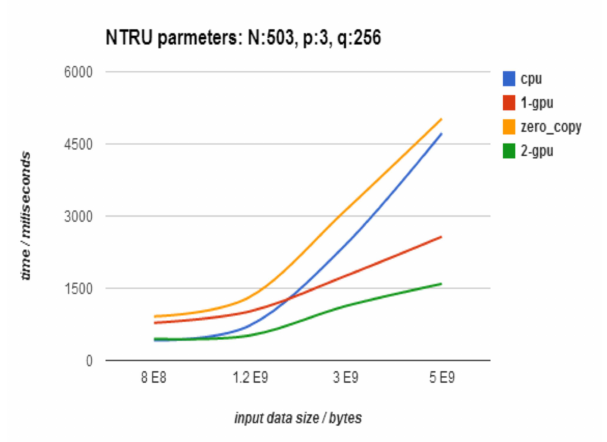
Fig. 7. Performance Comparison with Four